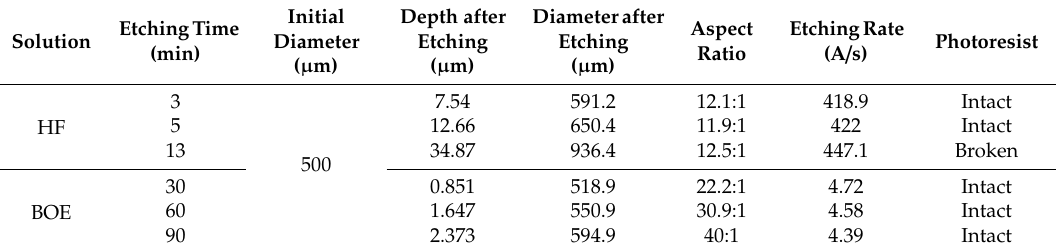
Table 6. Wet etching with the protection of 12- µ m-thick AZ4620 photoresist (Scheme II).